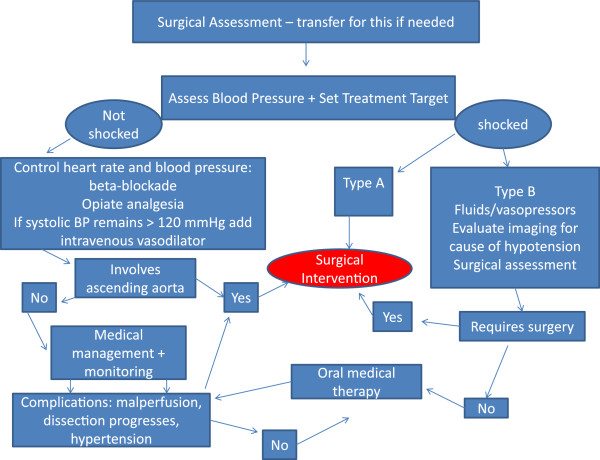
Management pathway for acute aortic dissection. Adapted from 2010 ACCF/AHA guidelines.